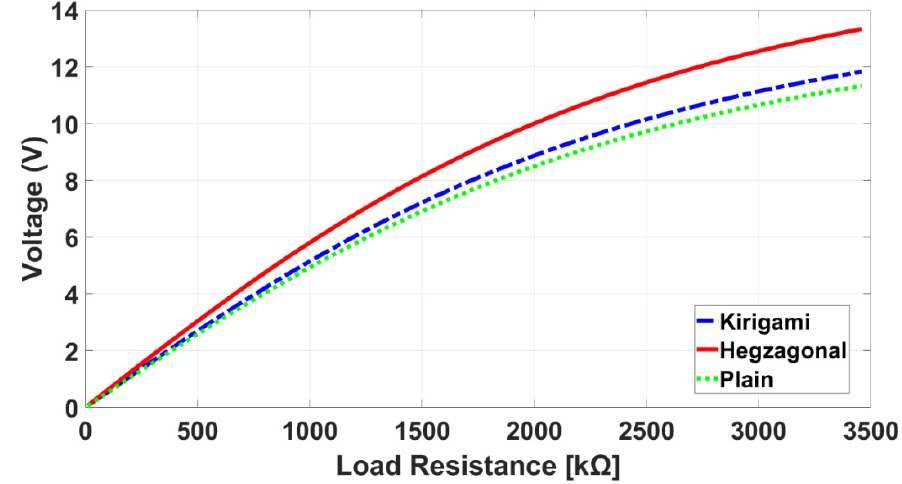
Figure 12. Comparison of simulated voltage output against load resistance for sensors.